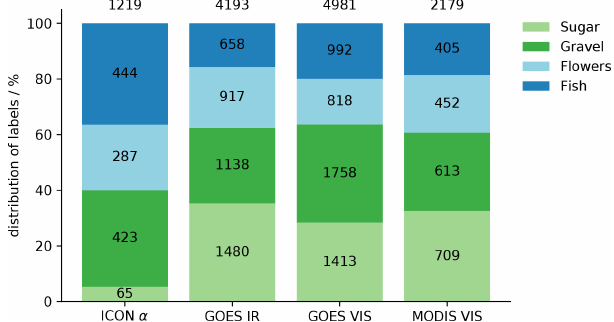
Figure 2. Distribution of labels by data source. The relative distri- bution is shown on the y axis, while the absolute number of labels is indicated within each bar. The total number of labels per workflow is shown on the top of each